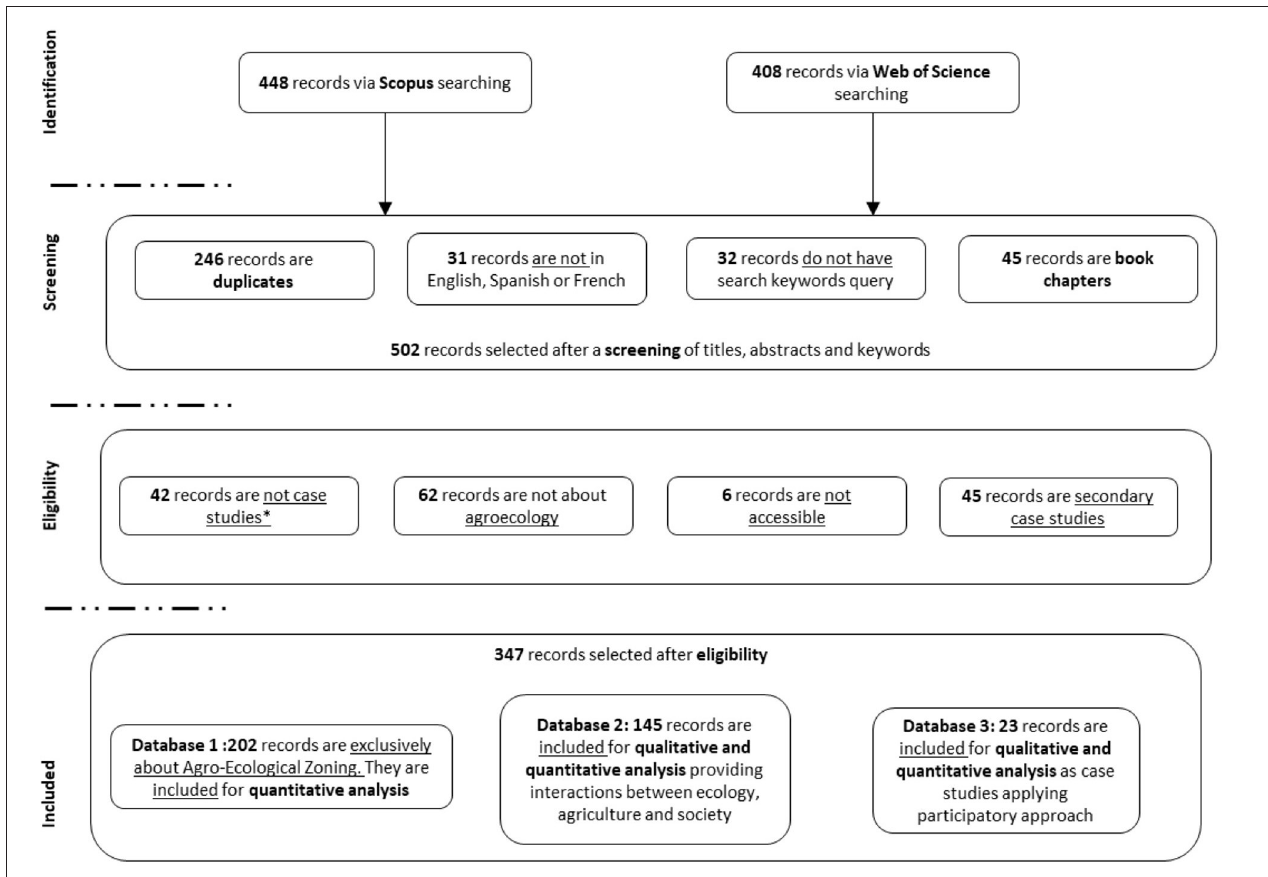
FIGURE 1 | PRISMA statement process undertaken for the selection of relevant articles. *22 records were annotated outlines; three records were literature reviews; two records were conceptual framework; two records were discussion paper; two records were editorial material; two records were about modeling without CS; one record was a forum paper; one record was a commentary; one record was a conference session summary; one record was a communication; one record was a dataset paper; one record was a Ph.D. thesis; one record was a review paper; one record was a synthesis; one record was a systematic review